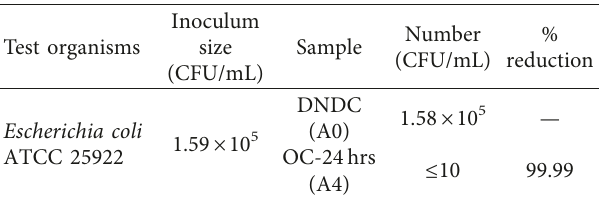
Figure 13: Agglutination of the blood test of (a) DNDC (A0) and (b) OC-24 hrs (A4). Table 4: Antibacterial activity test of DNDC (A0) and the OC- 24hrs